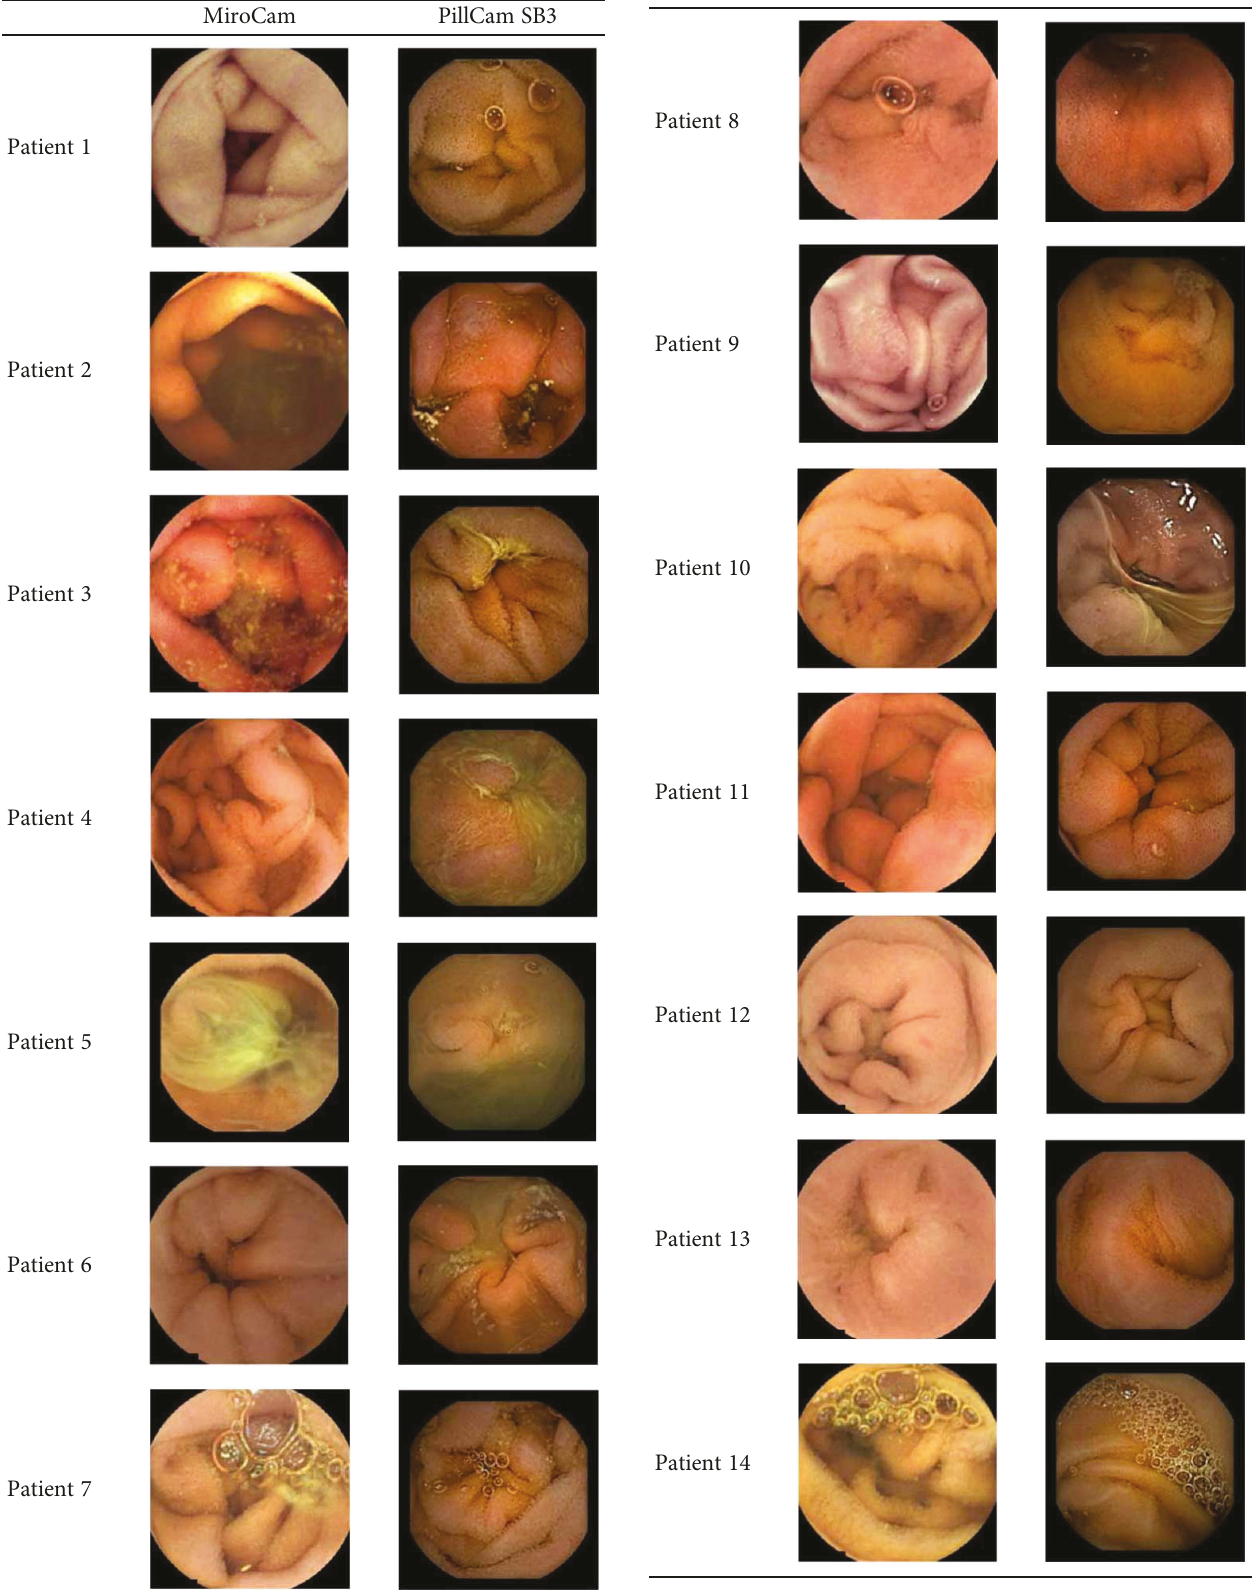
Table 2: Duodenal papilla detection via the MiroCam and PillCam SB3 capsule endoscopes.